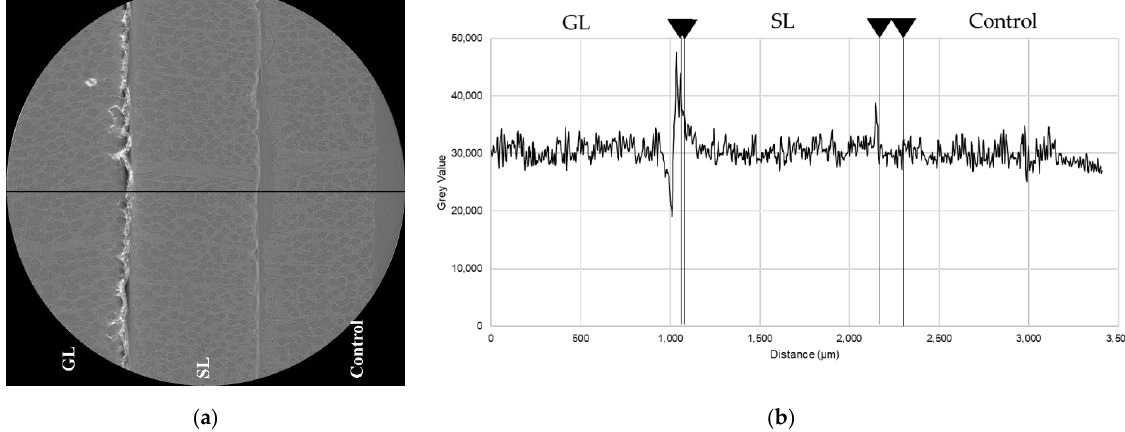
Figure 9. Sample series 1 Mo target with Al filter up side (GL, SL, control); ( a ) visualization result and the plot profile line; ( b ) plot profile graphic.